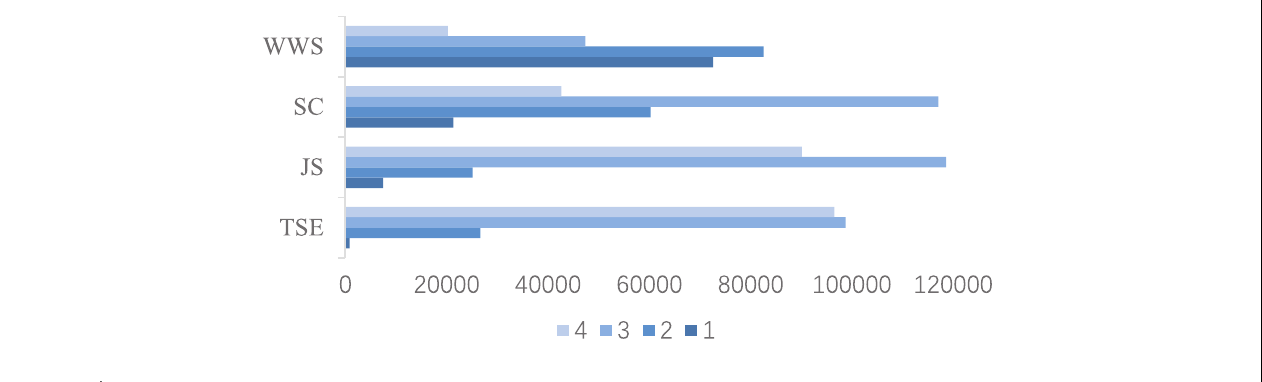
FIGURE 1 | Clustered bar of responses to each scale for total samples. options of all items for TSE, JS, and SC, respectively. For WWS, which can be treated as a negative sense, 133 teachers chose the first options of all